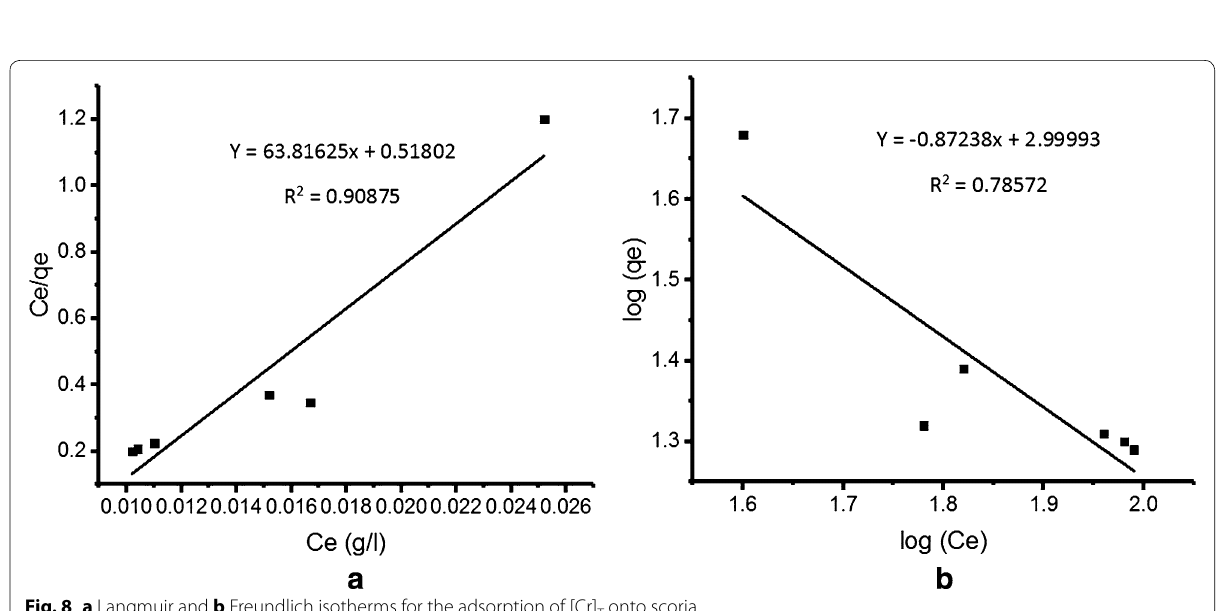
Fig. 8 a Langmuir and b Freundlich isotherms for the adsorption of [Cr] T onto